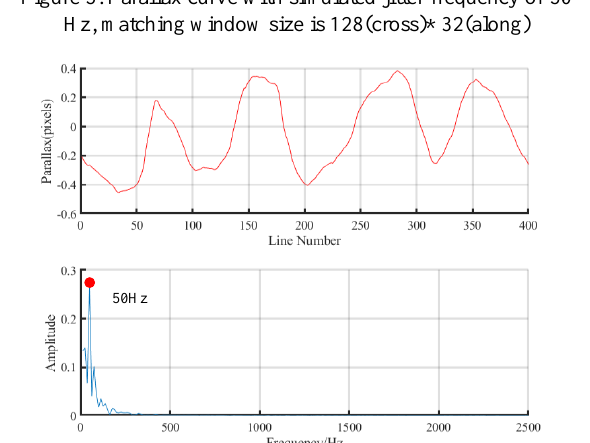
Figure 6. Parallax curve with simulated jitter frequency of 50 Hz, matching window size is 128(cross)* 64(along)